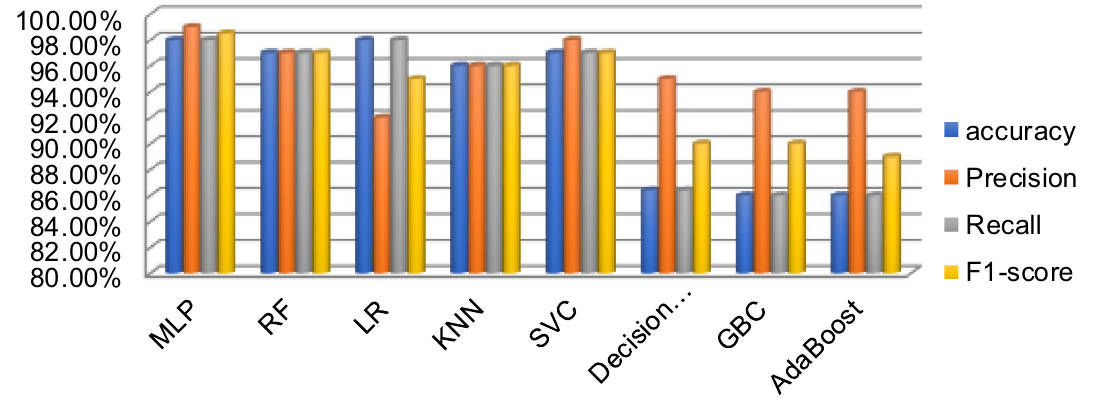
Fig. 5 Highest performance comparison of different classification algorithms on top 15